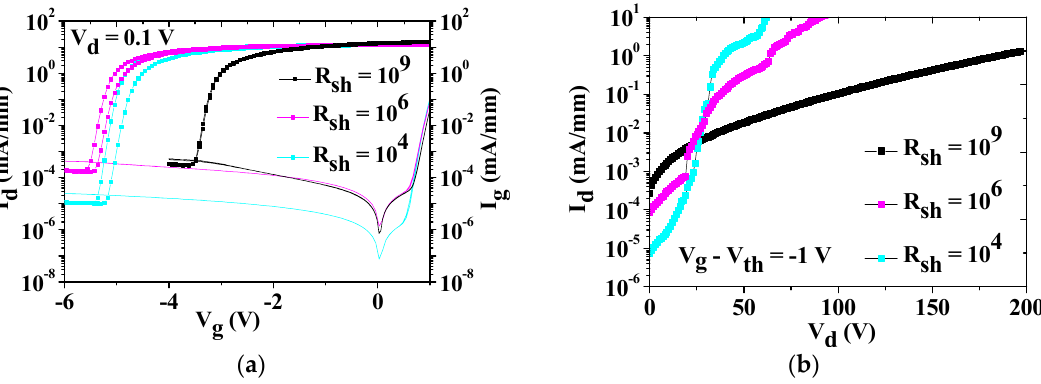
Figure 2. ( a ) Drain currents with double sweep of gate voltage at V d = 0.1 V and ( b ) breakdown voltages at V g = − 6 V in the fabricated AlGaN/GaN HEMTs with different GaN buffer resistance.